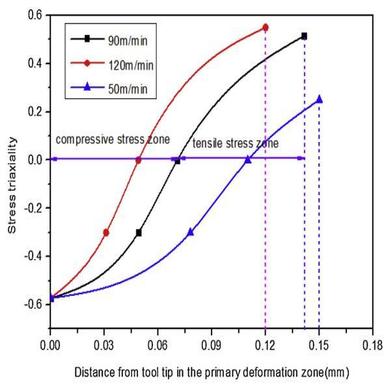
Distribution of stress triaxialities in the adiabatic shear band at different cutting speeds.